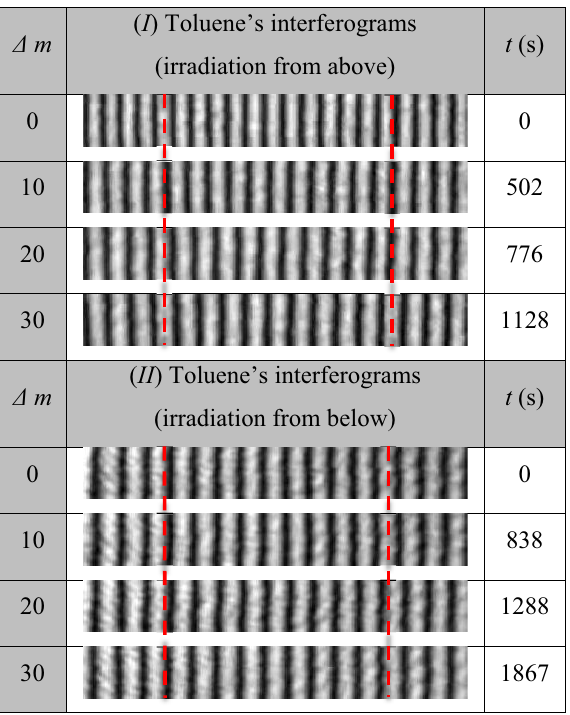
Figure 2. Some interference patterns for toluene at different times of the UV 254 exposure in case of (I) first and (II) second experimental procedures. The shown t -values are the instants when the corresponding Δm values are